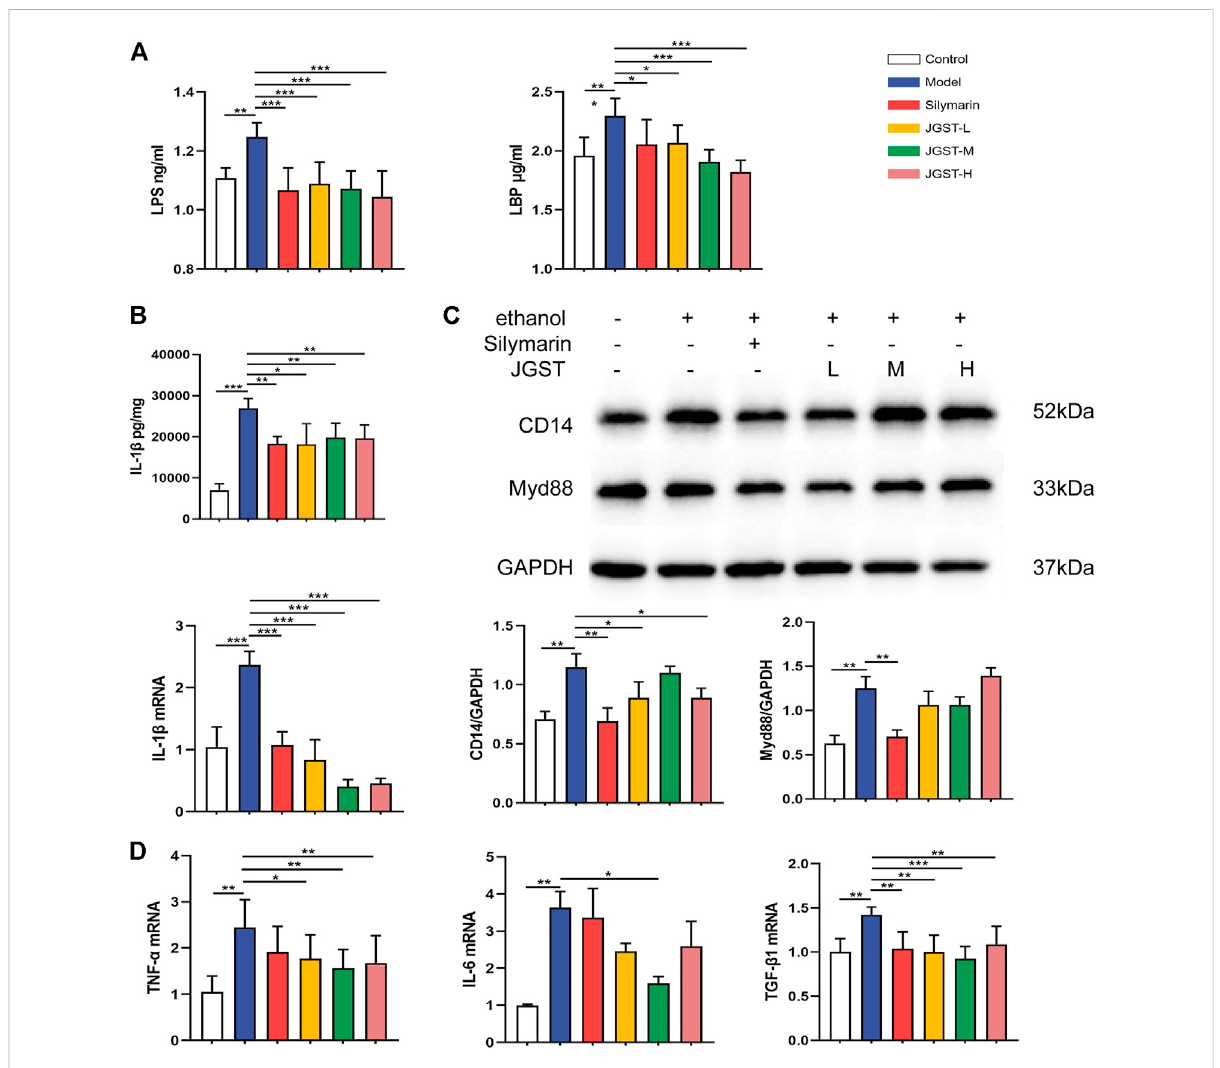
FIGURE 7 The effect of, IGST on in fl ammation in the liver of ALD mice. (A) Level of LPS and LBP in liver tissue. (B) Level and mRNA expression of IL-1 β . (C) The protein expression of Myd88 and CD14 in liver tissues. (D) mRNA expression of TNF-a, TGF- β , and IL-6 in liver tissues. Data were presented